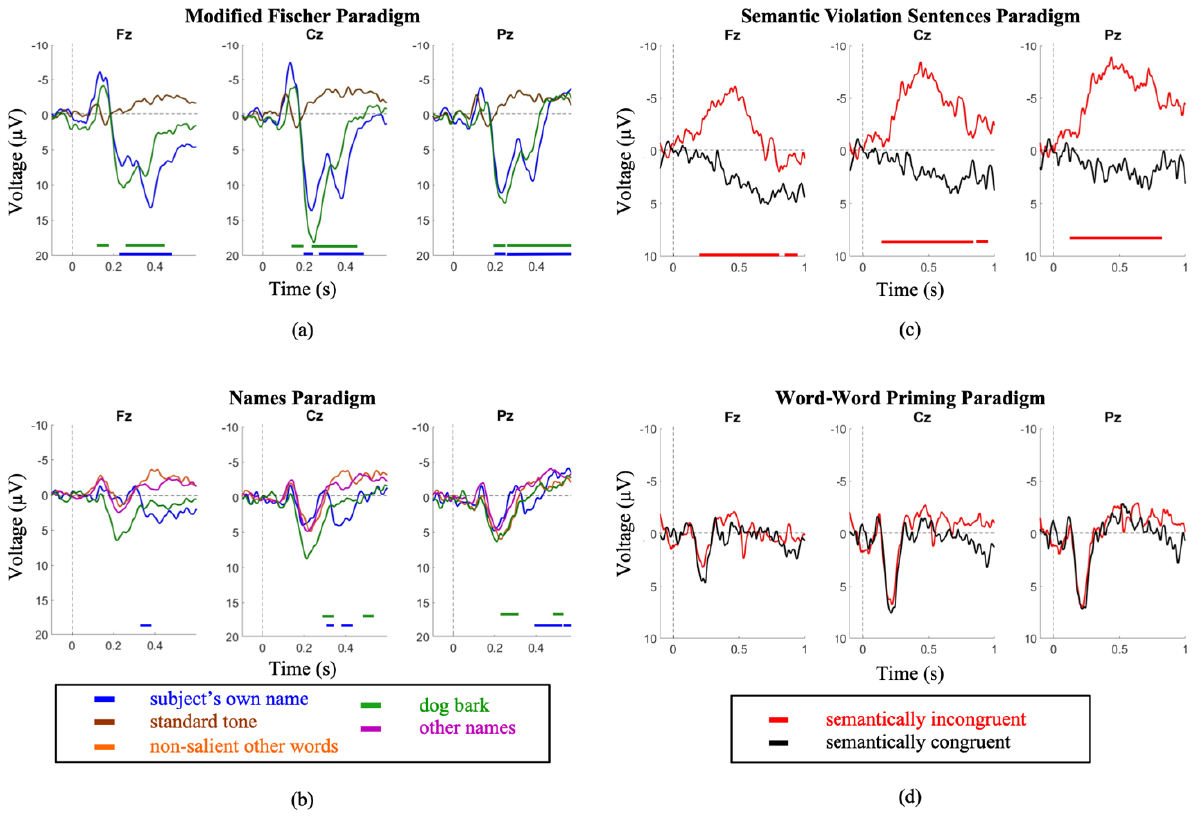
Figure 1. Youth group grand average waveforms. ( a ) A large P300 is elicited by the subject’s own name in the MF paradigm. ( b ) a less robust P300 is elicited by the same stimulus in the SON paradigm. ( c ) A clear N400 is elicited in the SVS paradigm. ( d ) no distinction between conditions is seen in the WWP paradigm. Intervals of significance are indicated by color-matched bars, where the waveform is significant in relation to the standard tone stimulus (MF paradigm), other names stimulus (SON paradigm), and semantically congruent stimulus (SVS paradigm).